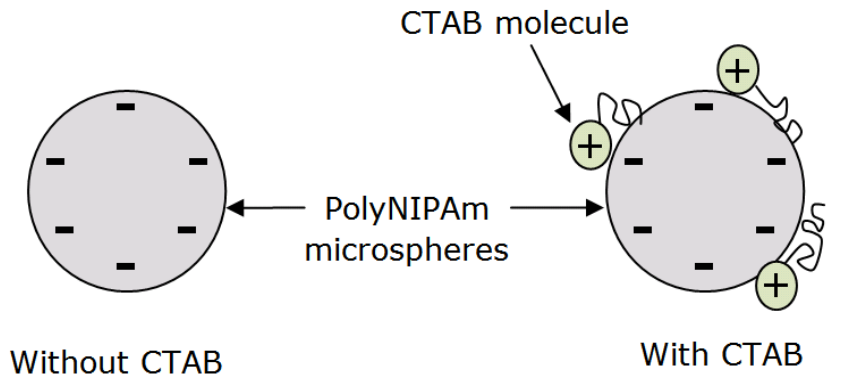
Figure 13. The adsorption of CTAB molecules onto a polyNIPAm microsphere surface via electrostatic attraction.